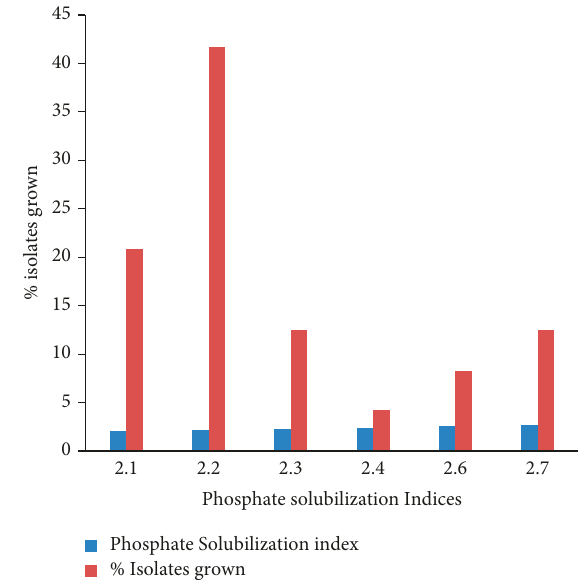
Figure 2: The pattern of phosphate solubilization index of Chickpea rhizobia isolated from chickpea.